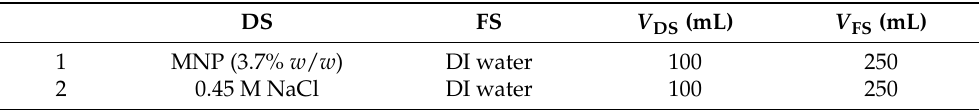
Table 1. Experimental